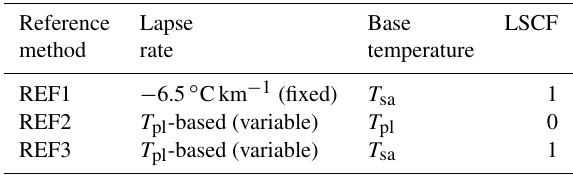
Table 2. Summary of reference